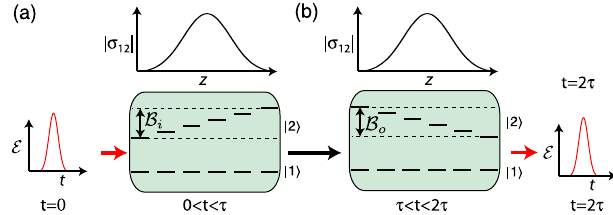
FIG. 1. Basic two-level gradient echo memory operation. (a) A ð t Þ , bandwidth B , and pulse with an input Gaussian envelope E i p center frequency ! enters the storage medium, at time t ¼ 0 , ci where the optical information is stored in the atomic excitation (cid:2) 12 . The memory has a linear frequency gradient placed along it . (b) At in the z direction and a input frequency bandwidth B i time t ¼ (cid:4) , the sign of the frequency gradient is reversed, with ¼ B . In this scheme, the the memory output bandwidth B o i ð t Þ ¼ E ð(cid:2) t Þ echo is emitted at time t ¼ 2 (cid:4) with pulse shape E o i ¼ ! and center frequency ! co ci